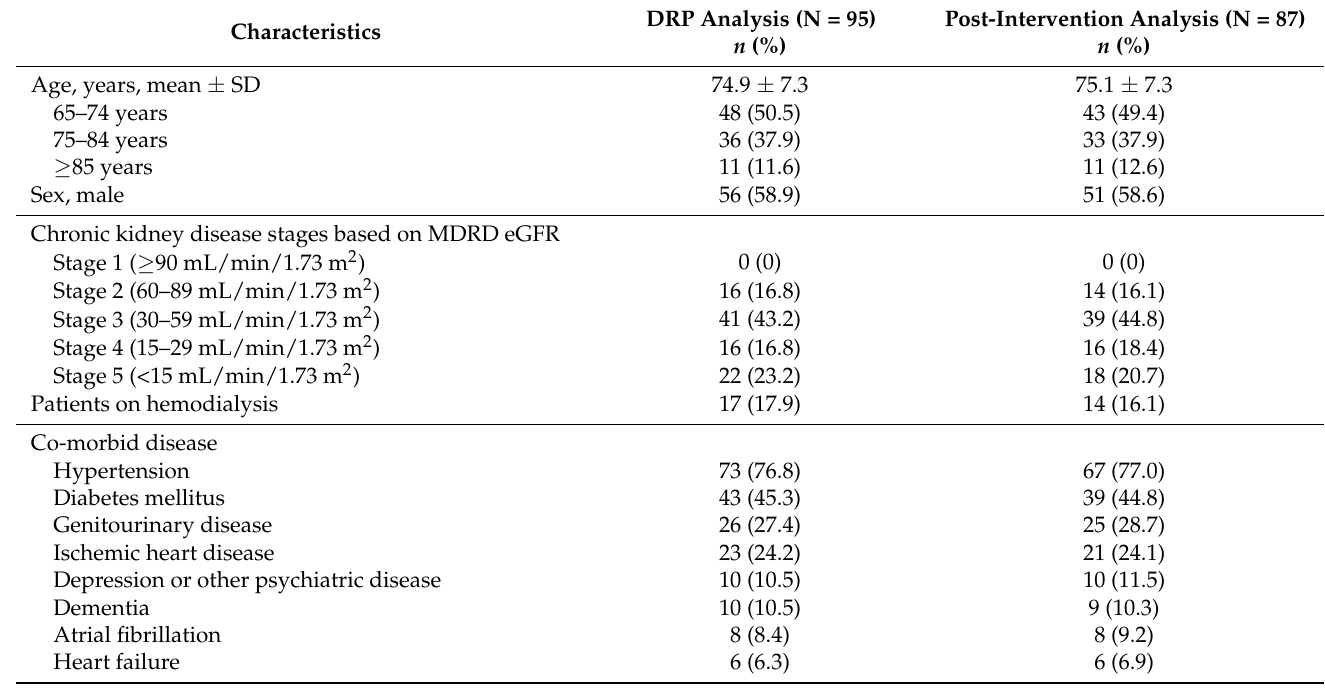
Table 1. Baseline characteristics of patients who received geriatric medication management